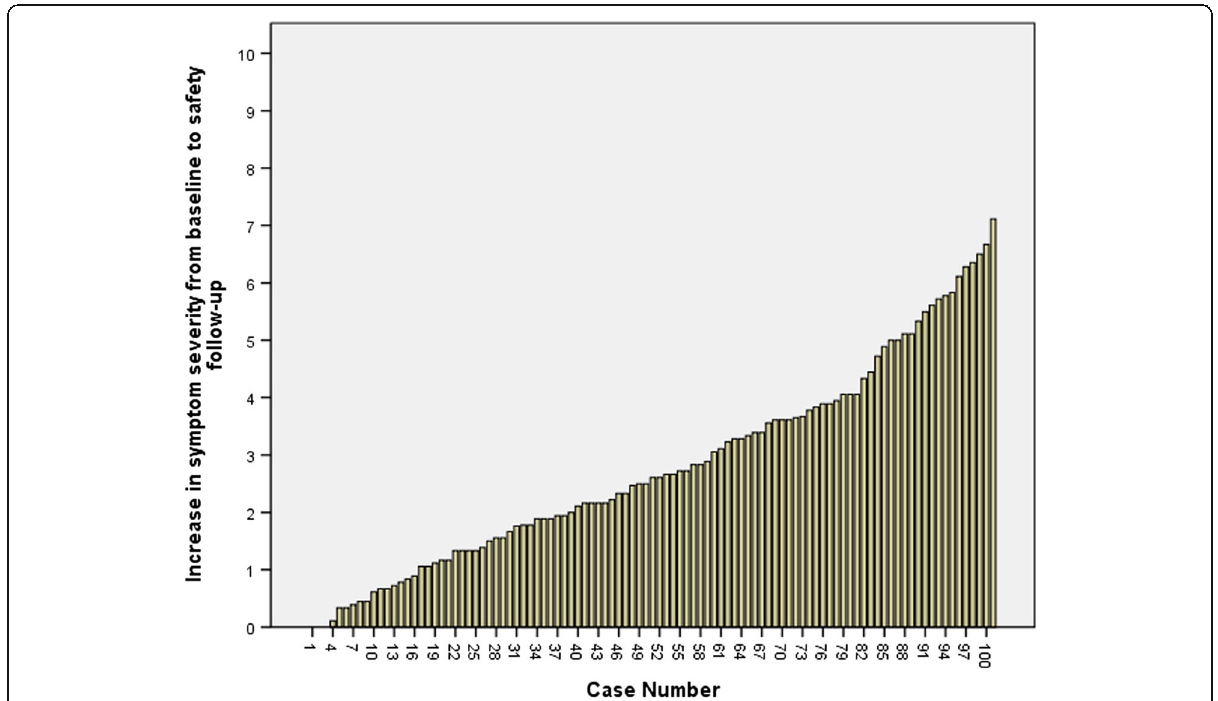
Fig. 2 Waterfall plot depicting changes in symptom severity scores from baseline to safety follow-up. All patients who completed both MDASI- MPM assessments at baseline and safety follow-up showed symptom worsening ( N = 98). About 86% of the patients had a 1-point or greater increase in symptom severity while 65% had a at least a 2-point symptom